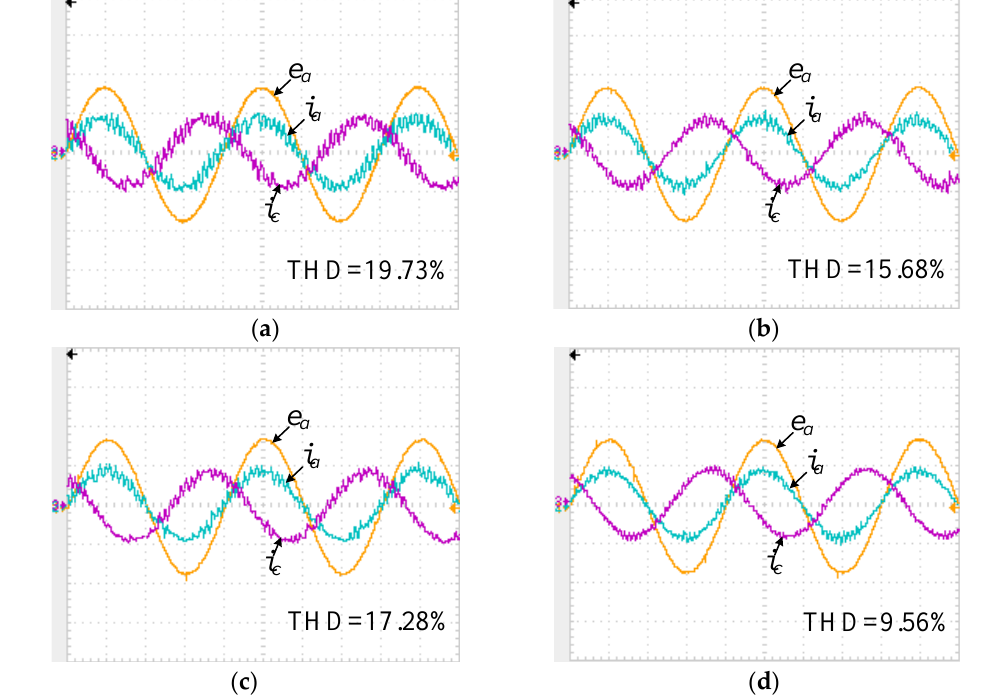
Figure 7. Steady-state performance of four MPC methods (20 V/div, 10 A/div, 5 ms/div): ( a ) MPC1; ( b ) MPC2; ( c ) MPC3; ( d ) Proposed MPC. MPC2; ( c ) MPC3; ( d ) Proposed